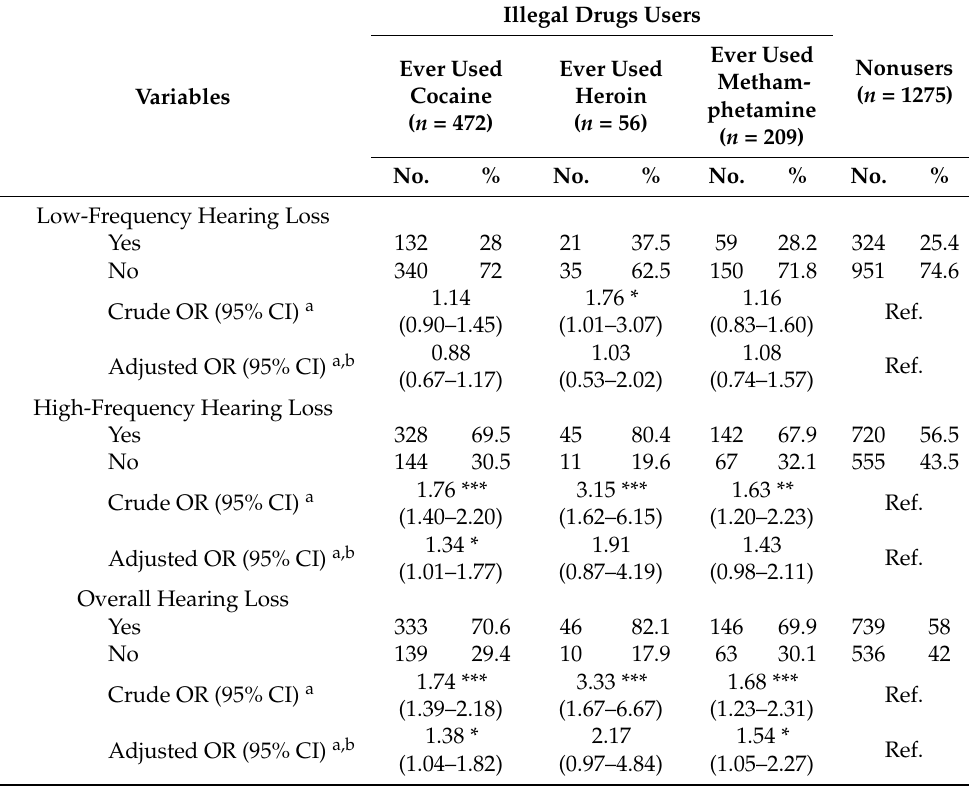
Table 4. Prevalence, odds ratios, and 95% confidence interval for low-frequency hearing loss, high- frequency hearing loss, and hearing loss, stratified by the type of illegal drug